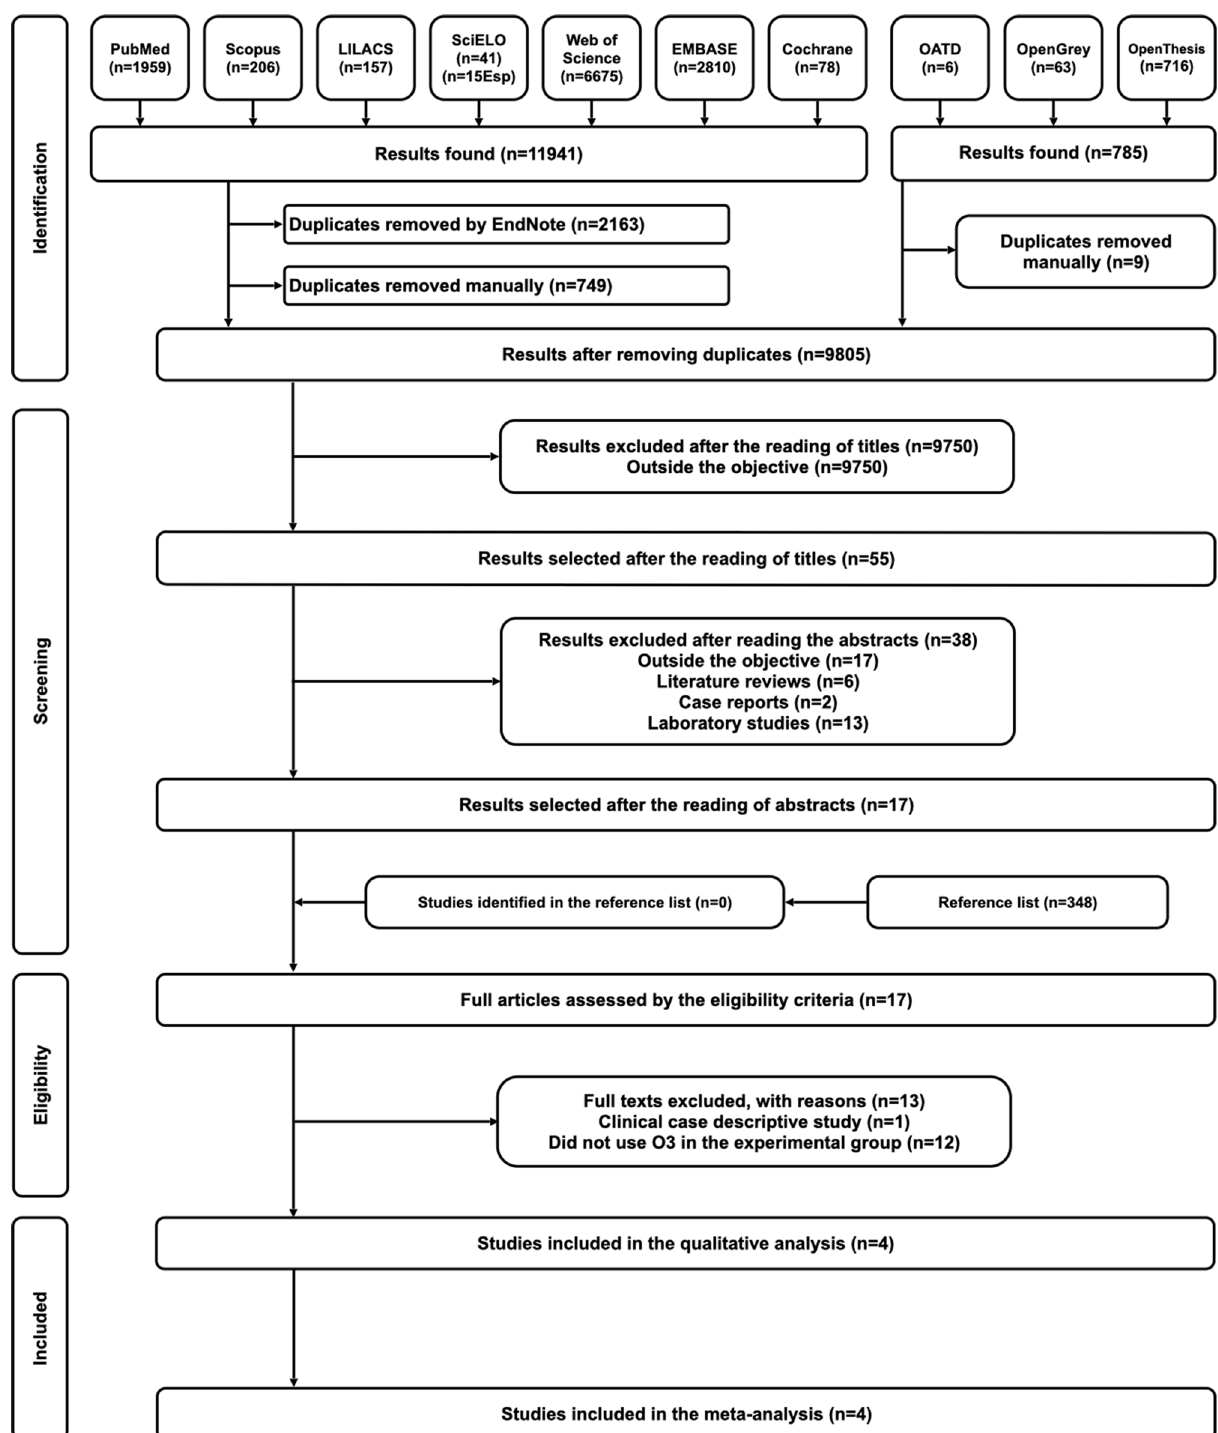
Figure 1. Flowchart of the process of literature search and selection, adapted from the PRISMA